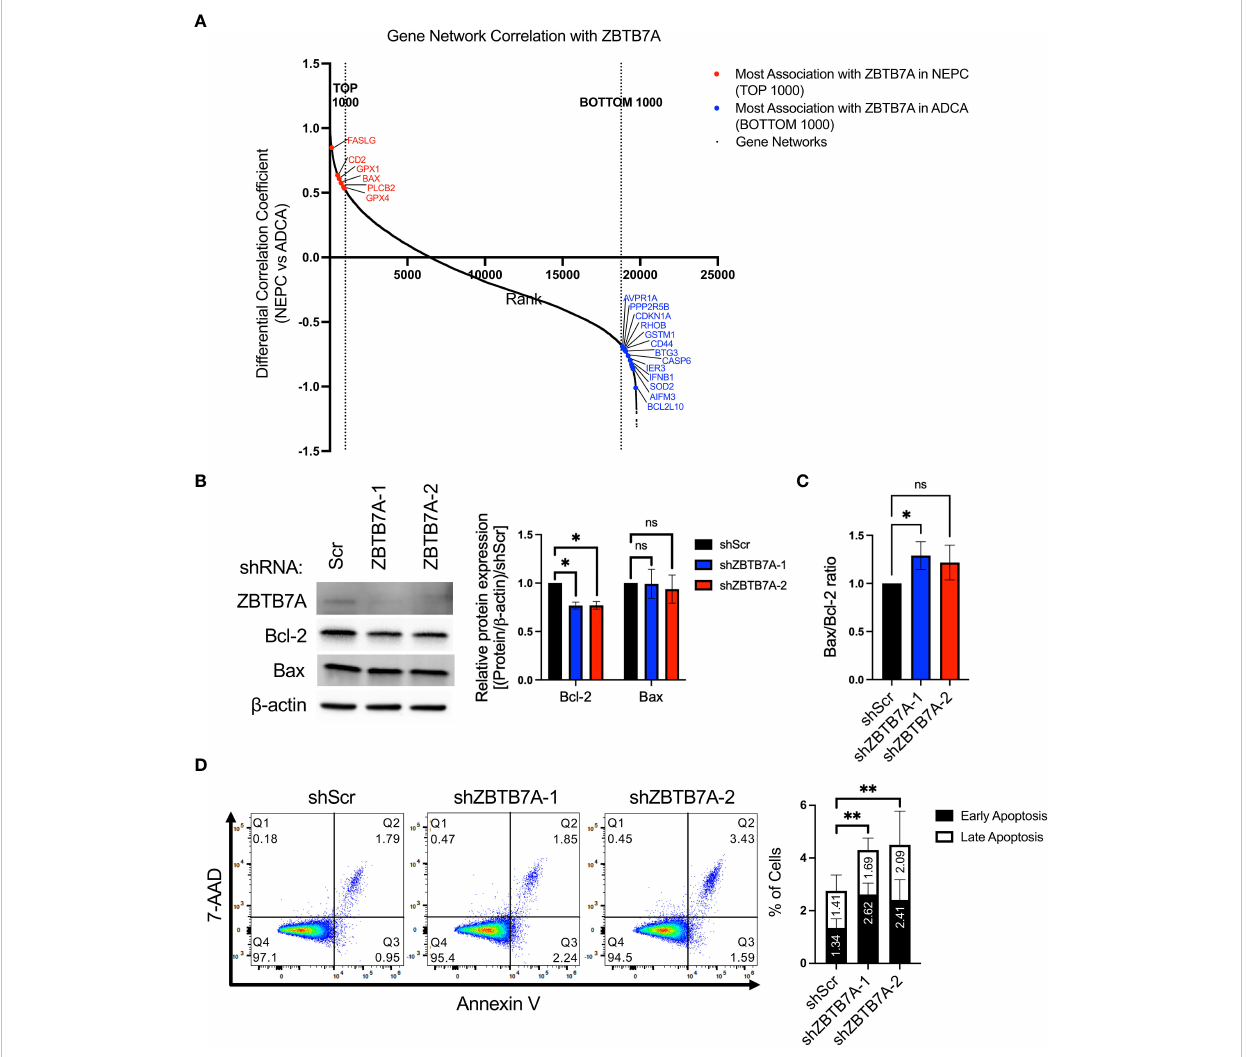
FIGURE 5 Gene network analysis and ZBTB7A perturbation revealed the association of ZBTB7A in suppressing apoptosis in NEPC. (A) Gene networks of apoptosis related genes are associated with ZBTB7A gene network in NEPC and ADCA. The gene network correlation coef fi cients of 19,769 genes present in both ADCA and NEPC patients were used. The gene networks associated with ZBTB7A were plotted in the rank order based on the differential gene network correlation coef fi cient values (see Methods). High differential correlation coef fi cient value indicates that a gene network is more associated with ZBTB7A in NEPC, while low value implies more association with ZBTB7A in ADCA. Red and blue dots represent the most associated gene networks of apoptosis related genes with ZBTB7A in NEPC and ADCA, respectively. (B) ZBTB7A, Bcl-2 and Bax protein expression in NCI-H660 shScr and ZBTB7A knockdown cells. Bcl-2 and Bax protein levels were quanti fi ed by densitometry using Image J. Bars represent the mean from four biological replicates, and error bars are SD. ns , non-signi fi cant, * p <0.05 by Kruskal-Wallis test. (C) Bax/Bcl-2 ratio was calculated using their quanti fi ed protein expression from each biological replicate in (B) . Bars represent the mean of relative differences to the ratio of shScr cells from four biological replicates, and error bars are SD. ns , non-signi fi cant, * p <0.05 by Kruskal-Wallis test. (D) Apoptosis assay in NCI-H660 shScr and ZBTB7A knockdown cells by fl ow cytometry using Annexin V-FITC/7-AAD double staining. Representative scatter plots of 7-AAD versus Annexin V. The stacked bars represent the mean percentage of early and late apoptotic cells from three biological replicates and error bars are SD. The total percentage of apoptotic cells was assessed using one-way ANOVA. ** p